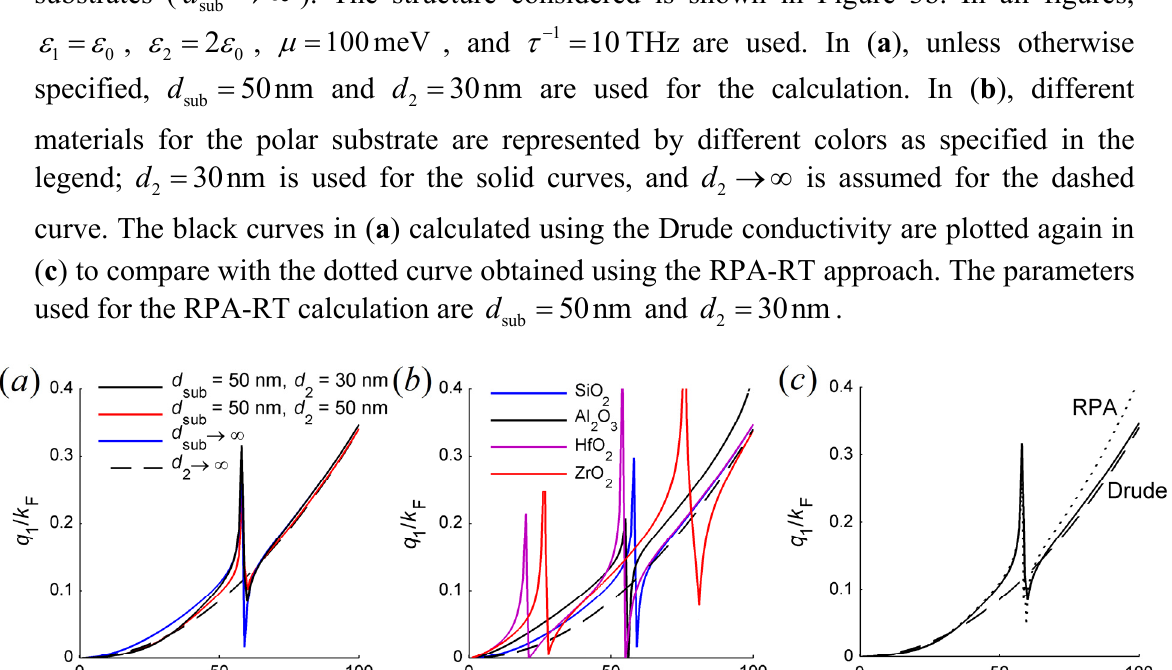
Figure 4. Plasmon dispersion of graphene on ( a ) SiO substrates